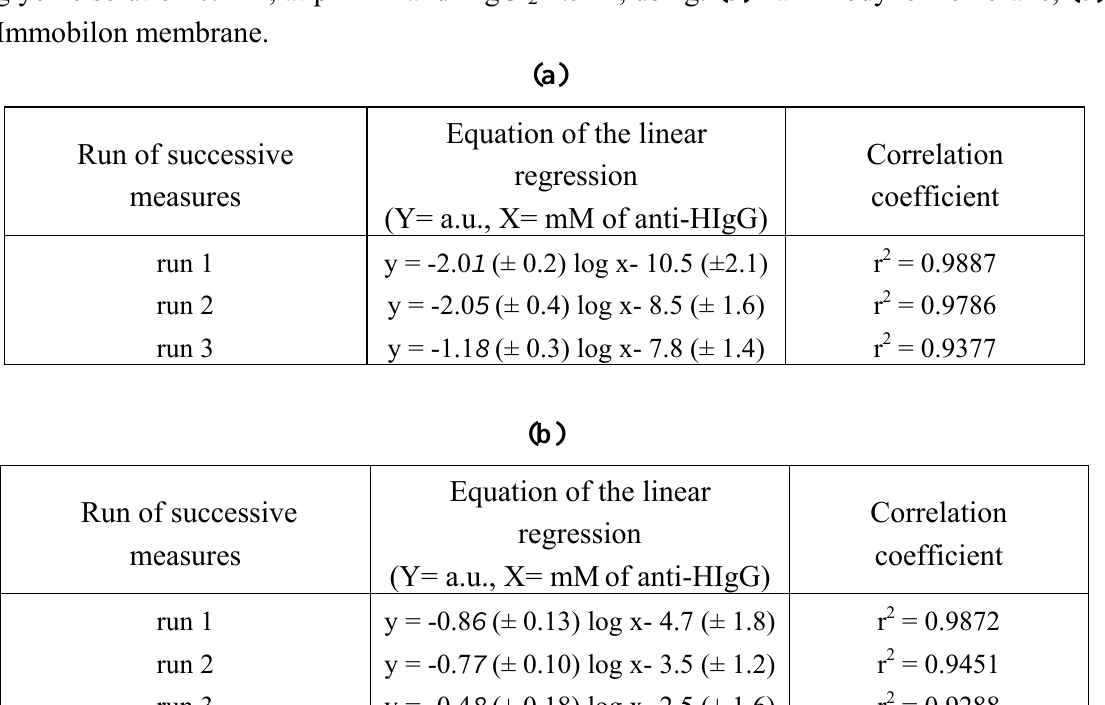
Table 4. Reutilization of the new immunosensor for anti-HIgG analysis after washing with glycine solution 0.1 M, at pH = 2 and MgCl Immobilon